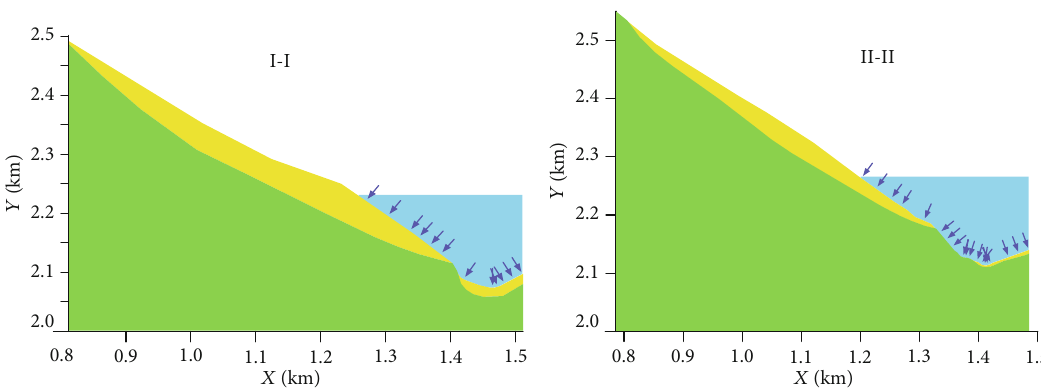
Figure 7: Simpli fi ed numerical model for calculation.